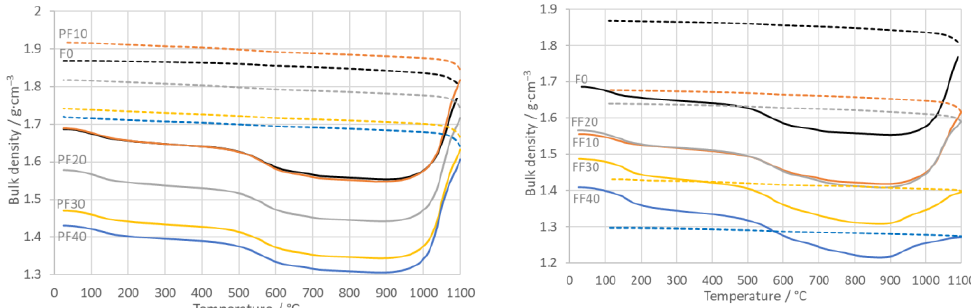
Figure 6. The bulk density of PF ( left ) and FF ( right ) samples (dashed lines correspond to the cooling stage of the firing).